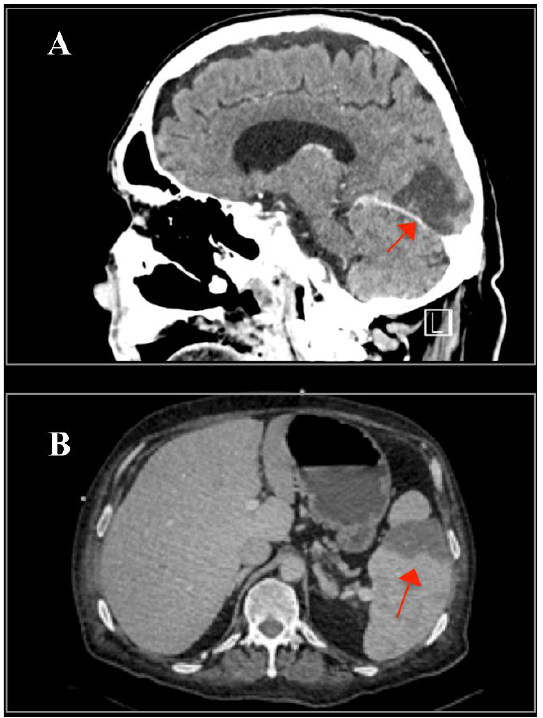
Figure 4. ( A ) Cerebral computed tomography (CT) demonstrating subacute right occipital stroke (arrow) and ( B ) abdominal CT showing one of the splenic infarctions (arrow).